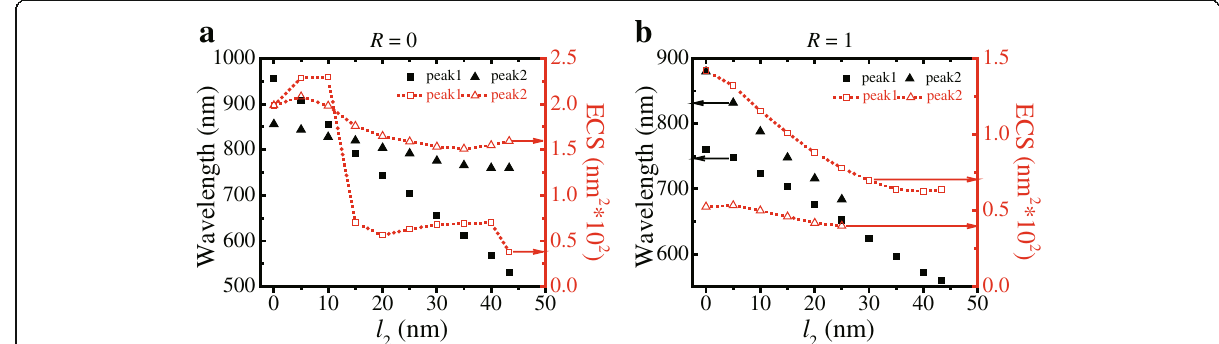
Fig. 4 ECS spectra of Ag TNP dimers with l 2 changing from 0 to 43.3 nm. a R = 0; b R = 1. The dark scatter and red short dot lines show the resonant wavelength and intensity spectra, respectively. The square and triangle lines show peak 1 and peak 2, respectively